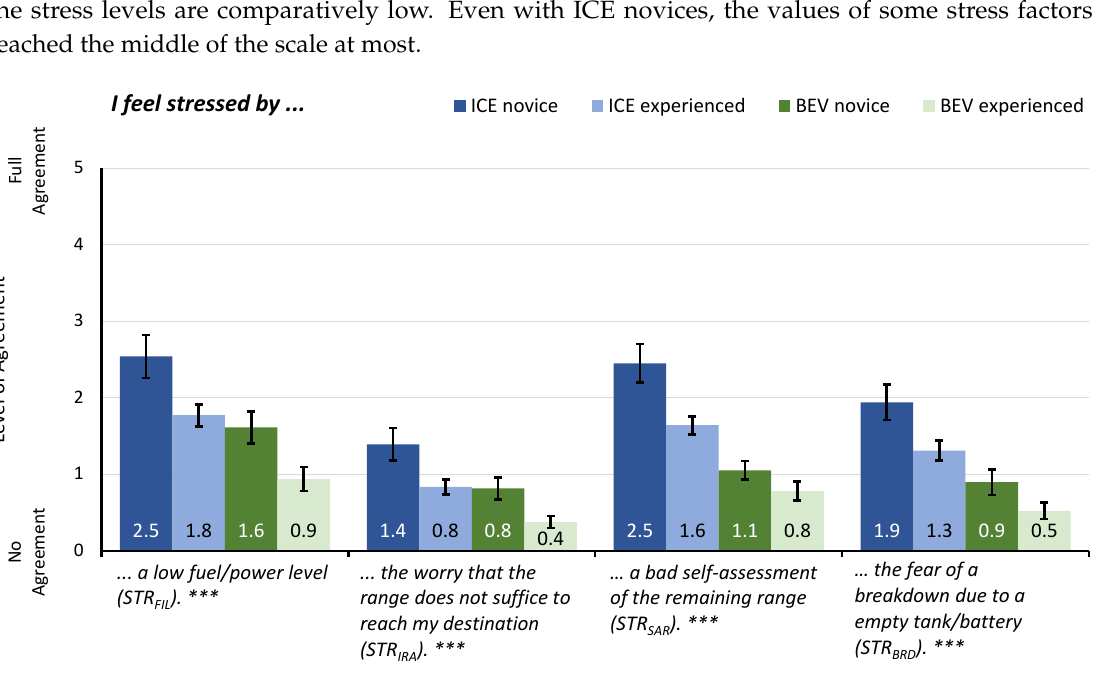
Figure 2. Perceived range stress differentiated by experience groups (Means and related Standard Errors, scale min = 0, scale max = 5, *** corresponds to p <